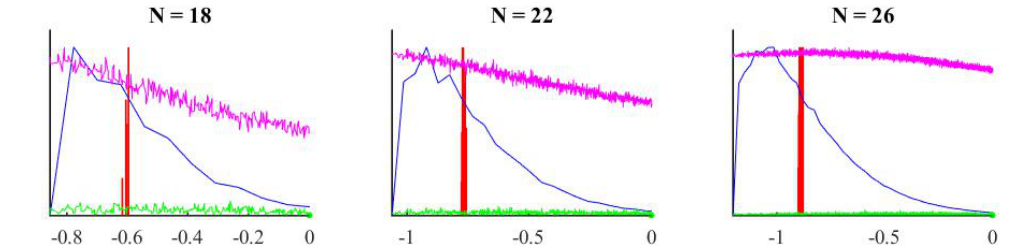
Figure 22 . The diagonal elements of f 1 ( t ) ; 2 (0) g 2 at scrambling time (magenta) dominate over the superdiagonal (green) and is slowly varying in the energy region of the thermal ensemble (blue) and the equilibrium state (red).